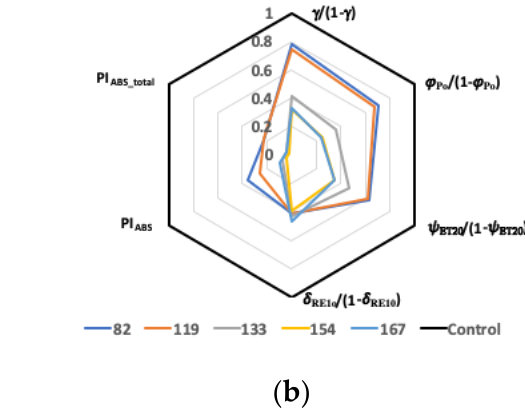
ABS ( a ) and PI ABS_total ( b ), from DAT 82 to DAT 167. Values